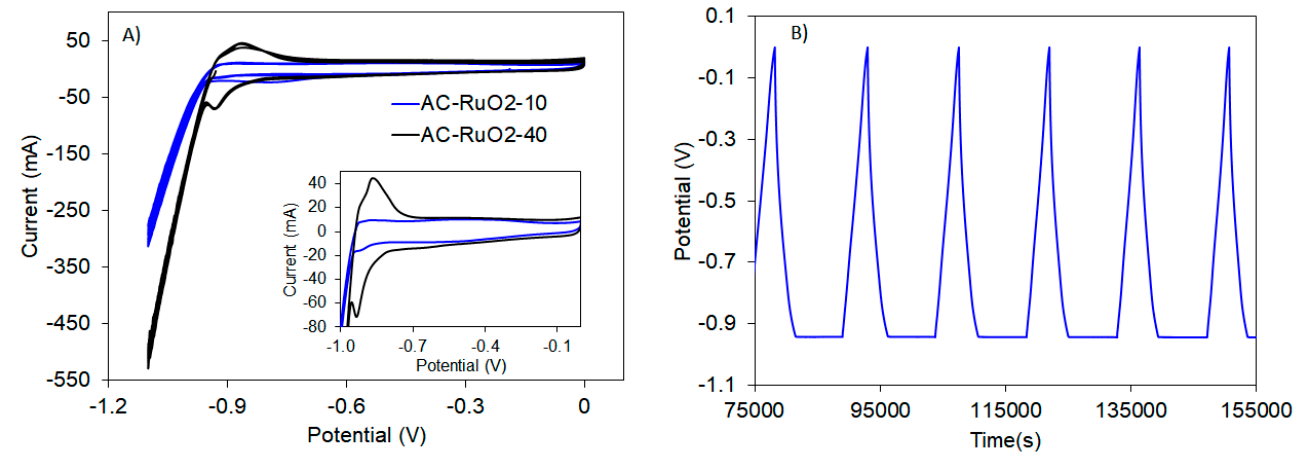
Figure 12. ( A ) CV of AC-RuO 2 -10 and AC-RuO 2 -40 in 6M KOH electrolyte, scan rate: 5 mV s − 1 . Inset: n = 30. ( B ) Galvanostatic charge-discharge curves using AC-RuO 2 -10 in 6 M KOH with specific current of 0.10 A g − 1 .